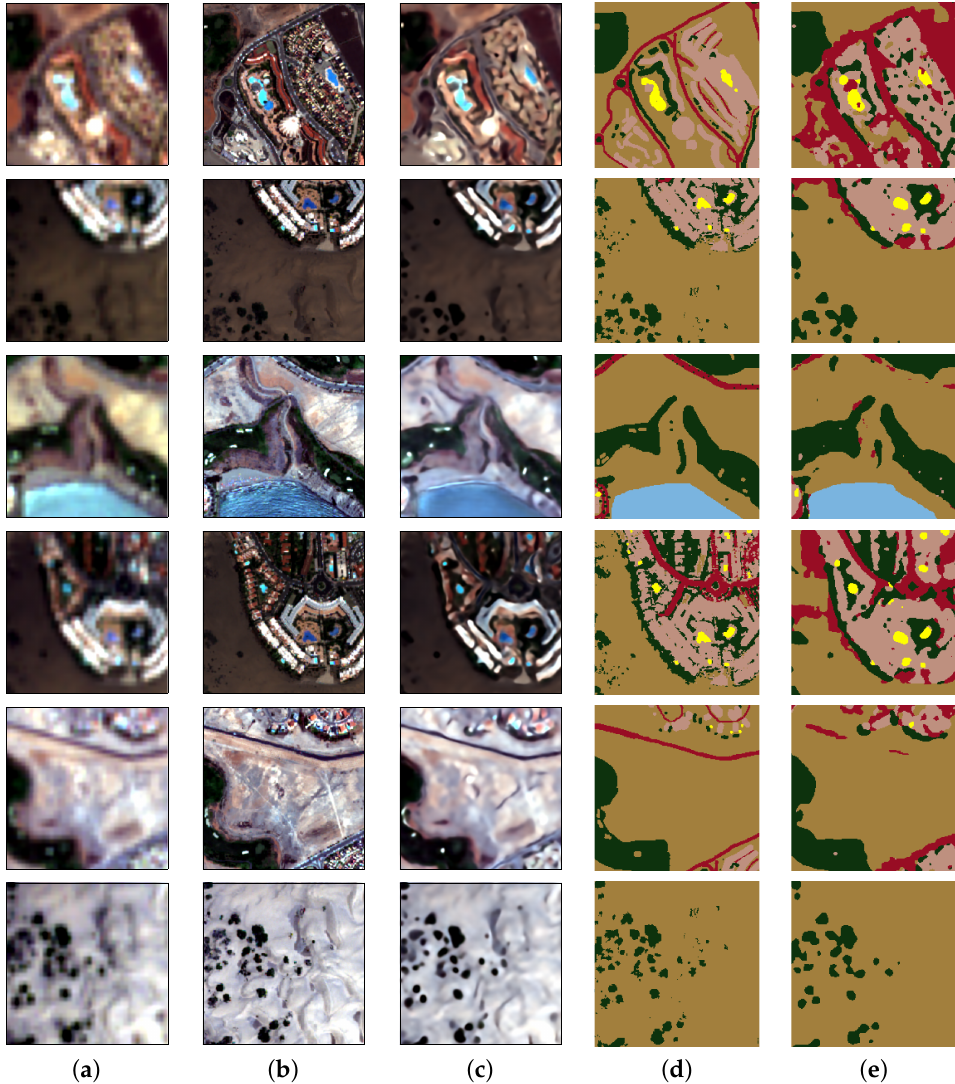
Figure 12. Zoom results obtained on different locations from the Test Set of the dataset: ( a ) Sentinel-2 bicubic input image, ( b ) WorldView-2 GT, ( c ) SISR result, ( d ) SSSR GT, ( e ) SSSR result. The colormap is the same as depicted in Figure 2. Image size 200 × 200